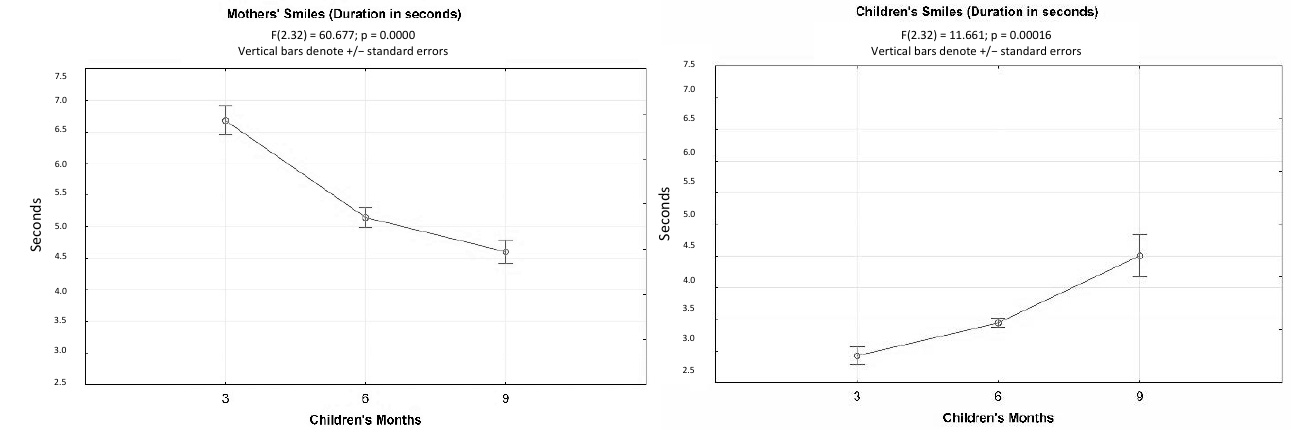
Figure 3. ANOVAs for repeated measures of mean. The duration of maternal smiles and infant smiles at three, six, and nine months.